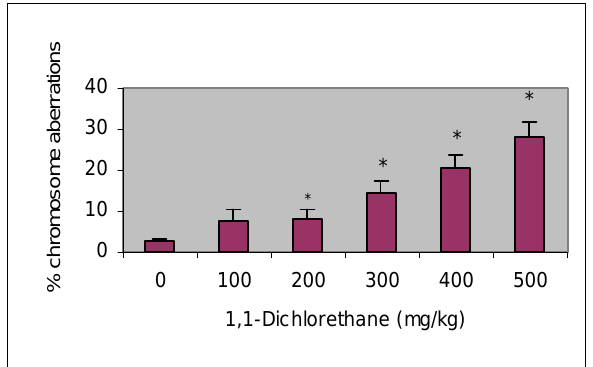
Figure 1 : Effect of 1,1-Dichloroethane on the frequency of chromosomal aberrations.